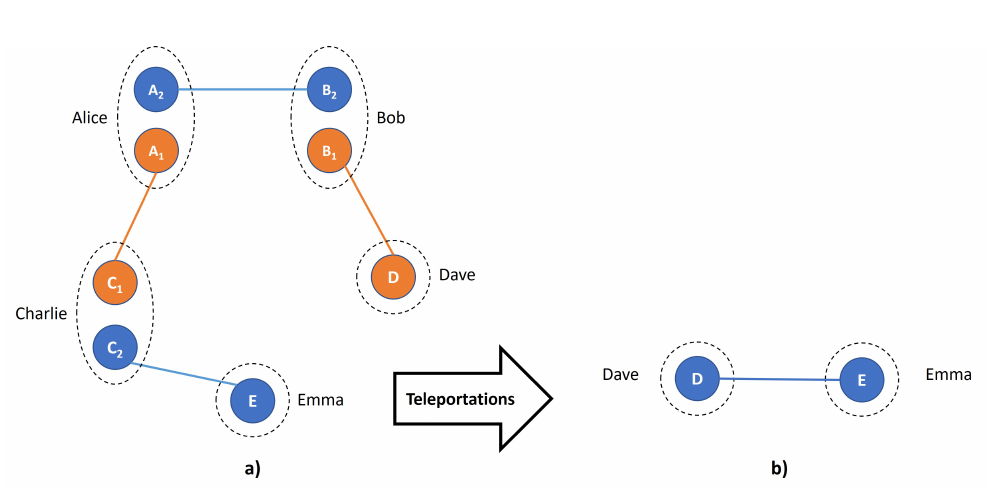
Figure 1. Superactivation of bound entanglement (BE) introduced by Shor et al. [13]. ( a ) Alice and Charlie are given a Bell state of qubits A 1 and C 1 , but they do not know which Bell state it is. The same state is given to Bob and Dave (qubits B 1 and D ), and they do not know which state is given, too. In the same way, pairs Alice and Bob, and Charlie and Emma, are each given an unknown but the same Bell states of qubits A 2 – B 2 and C 2 – E . Both four-qubit systems are BE. ( b ) Following a systematic teleportation procedure, qubits D and E are left in a Bell